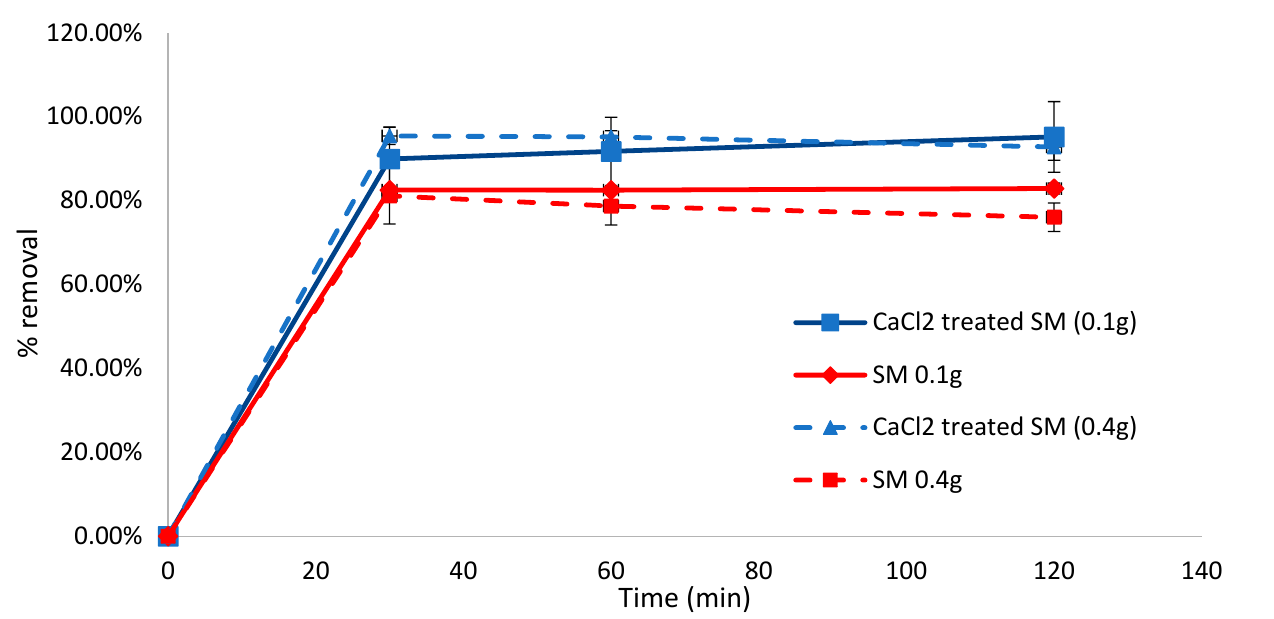
Figure 2. Biosorption of methylene blue over 120 min using CaCl 2 -pretreated or untreated Sargassum muticum (SM) (0.1 and 0.4 g). Standard deviation n = 3.